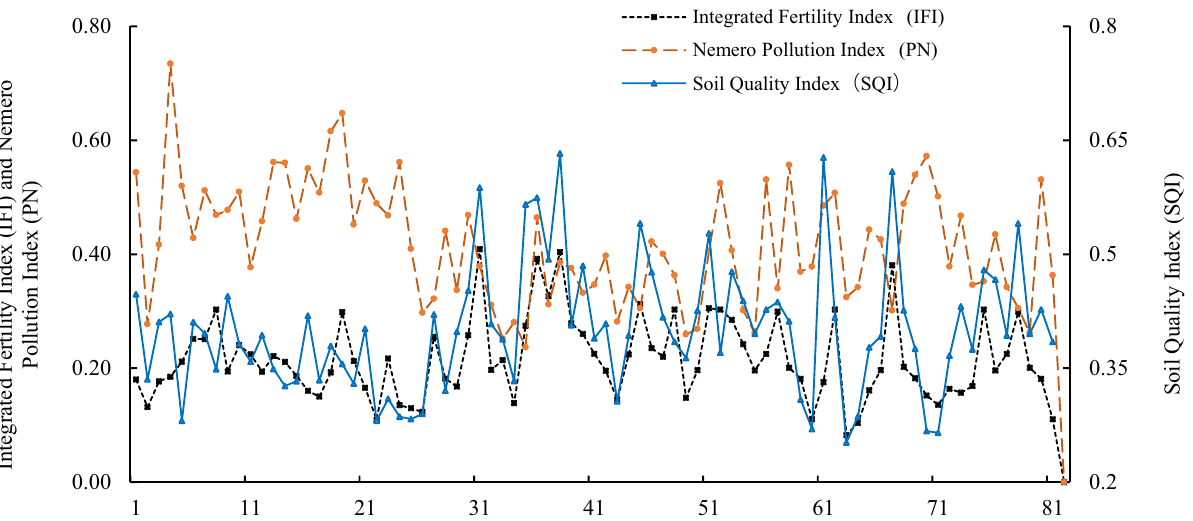
Figure 4. Comparative analysis between the three soil quality evaluation